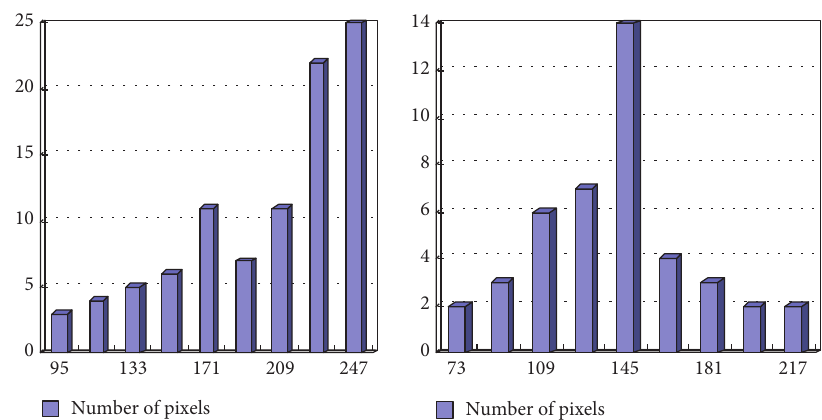
Figure 4: Histogram for the statistical analysis of equipment abnormality.